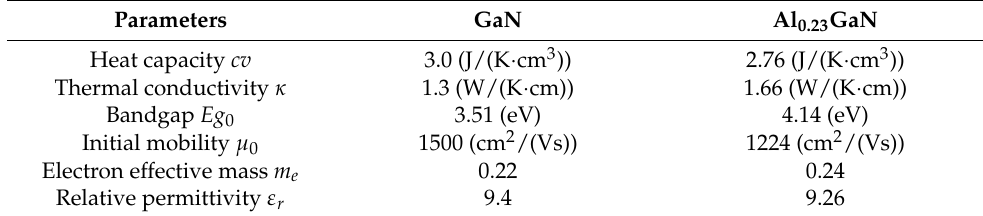
Table 1. The initial value (T = 300 K) of the key